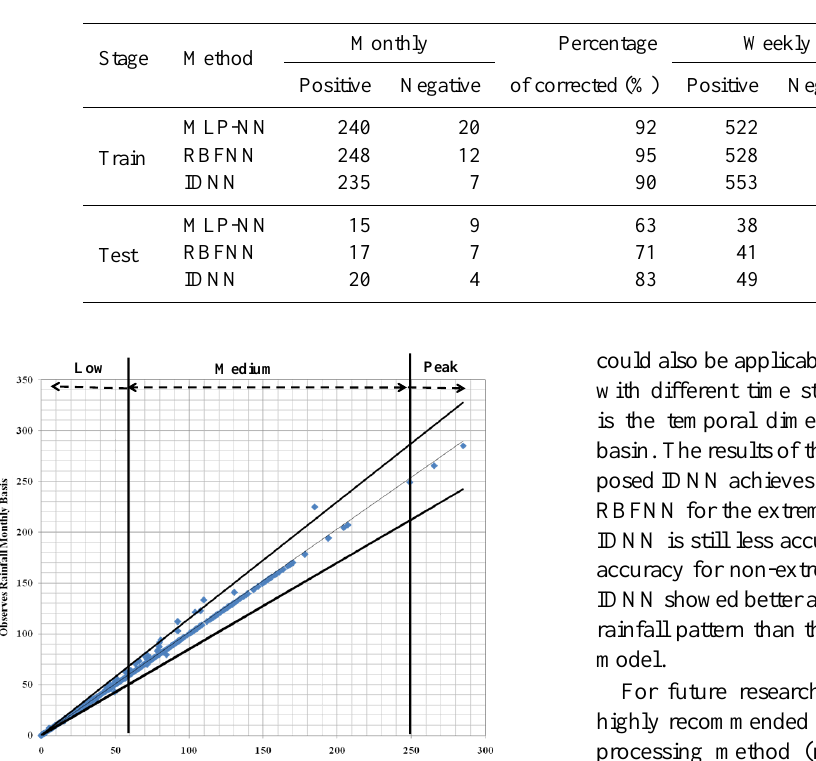
Table 5. Models performance for matching the rainfall consequences.